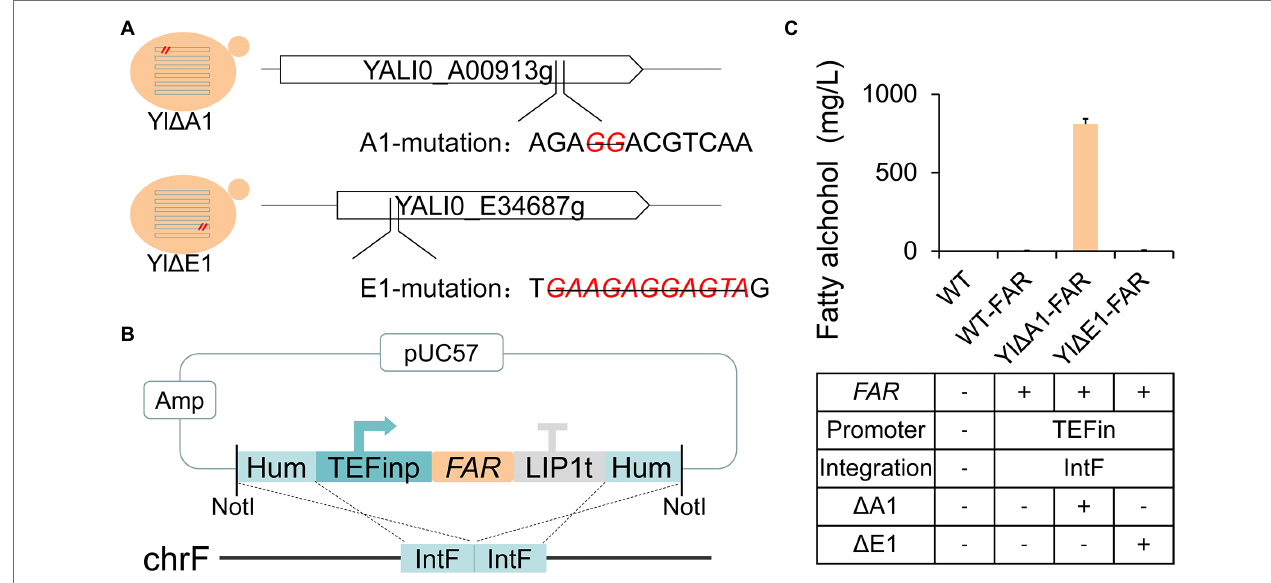
FIGURE 3 | Reverse engineering of the candidate targets derived from WGS to identify beneficial gene for enhanced fatty alcohol production. (A) CRISPR/Cas- mediated knockout of candidate gene targets in wild-type Y. lipolytica strain ATCC 201249. The deletion of bases at A1 and E1 sites in ATCC 201249 genome were marked with red and strikethrough. The knockout location is contained within the location of the broken vector fragment insertion. (B) Schematic diagram of the plasmid pIntF- FAR used to transform Y. lipolytica . The FAR gene is driven by the TEFin promoter and flanked by 2 homology arms of IntF location. The plasmid was linearized by NotI and transformed into different basic strains and two transformants were randomly selected from each plate for fermentation. (C) The effect of A1 and E1 sites disruption on fatty alcohols production. All strains were cultured in rich YPD medium. Values are the mean of three biological replicates ± standard deviation ( n = 3) after 72